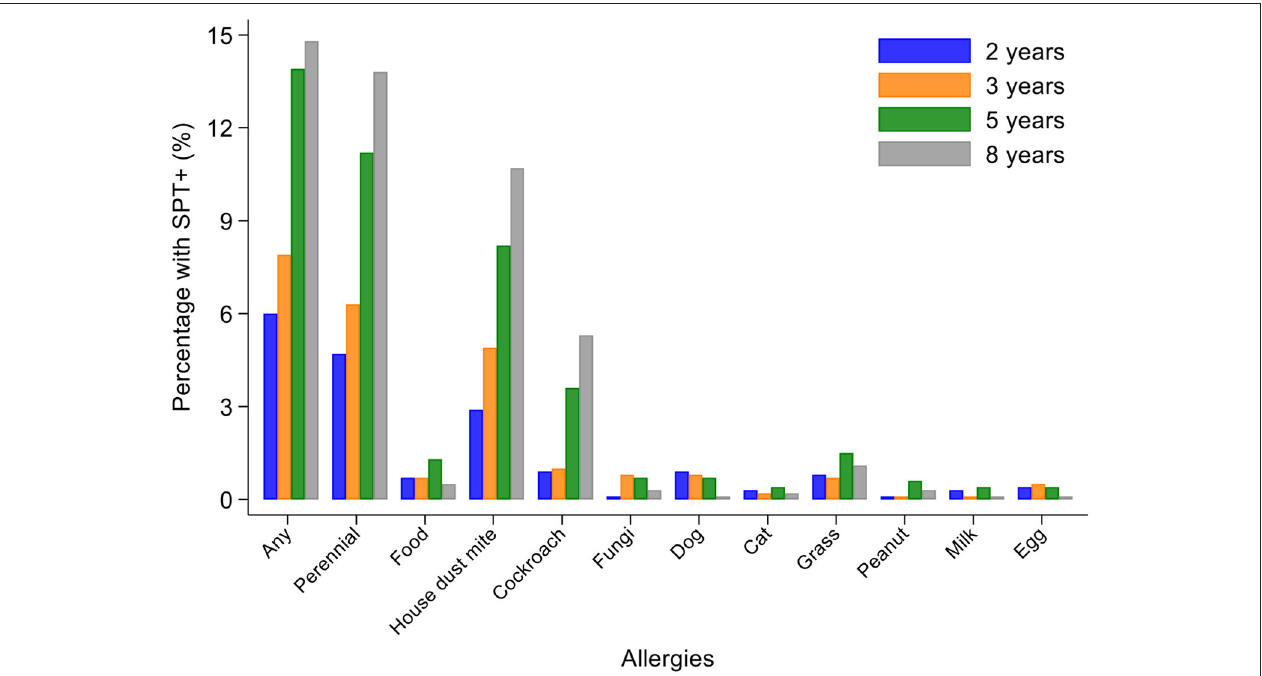
FIGURE 3 | Changes in allergic sensitization profiles between 2 and 8 years of age in cohort. Bars represent 2 (blue), 3 (orange), 5 (gray), and 8 (yellow) years. Perennial allergens included mite, cockroach, dog, and cat allergens.